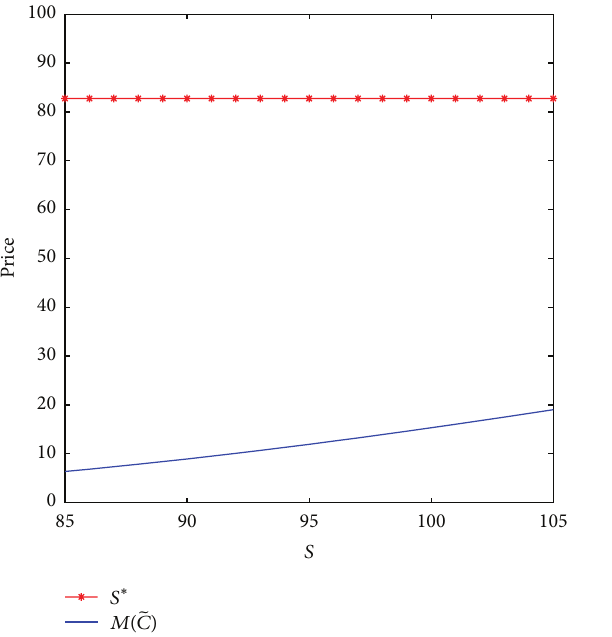
Figure 3: The sensitivity analysis of 𝑆 ∗ and